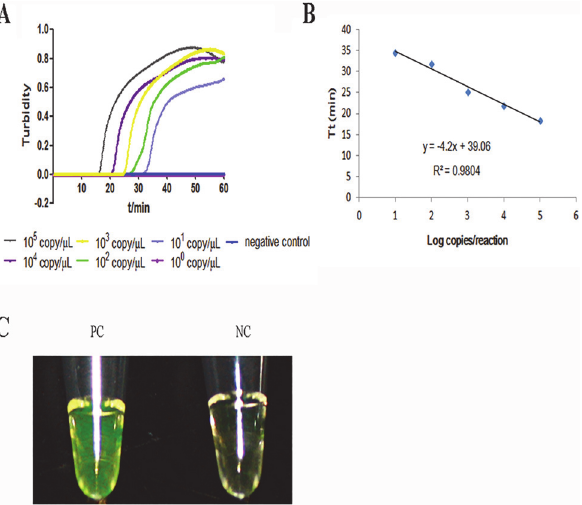
Fig 2. The real-time amplification of the STY2879 gene by LAMP. A. The real-time sensitivity of STY2879-LAMP as monitored by measurement of turbidity (optimal density at 650 nm). A turbidity of (cid:1) 0.1 was considered to be positive for STY2879-LAMP. Ten-fold serial dilutions of the reference plasmid pEASY-T1-STY2879 ranging from 1.5 × 10 5 to 10 0 copies/reaction were tested. B. The relationship between the threshold time (Tt) of each sample and the log copies/reaction. The standard curve was drawn on the basis of three independent repeats and the linear relationship R 2 = 0.9804. C. A direct visual detection by the naked eye with the addition of the FDR dye, which was added prior to the amplification. The original orange color of the FDR changed to green in the case of a positive amplification under natural light, whereas the original orange color was retained for a negative